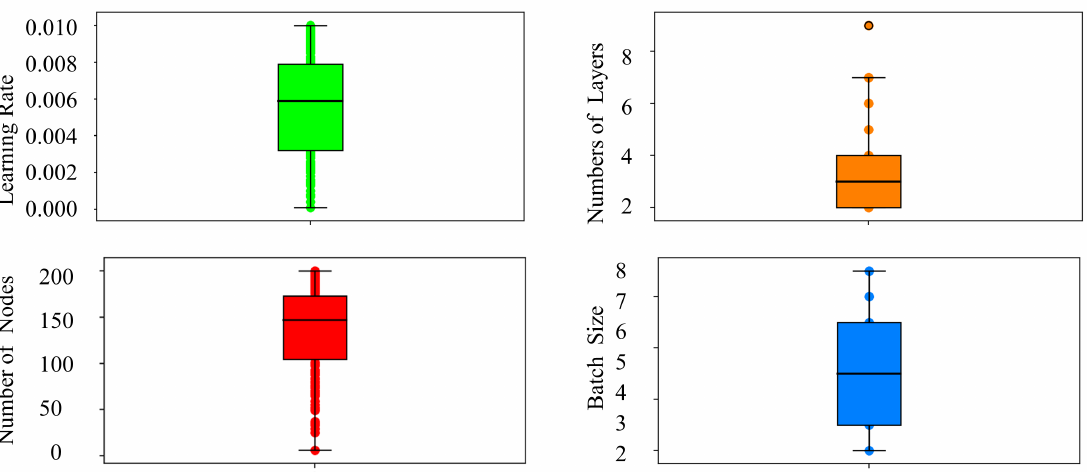
Figure 5. Distribution of the parameters of the optimized for 180 country specific Long Short-Term Memories